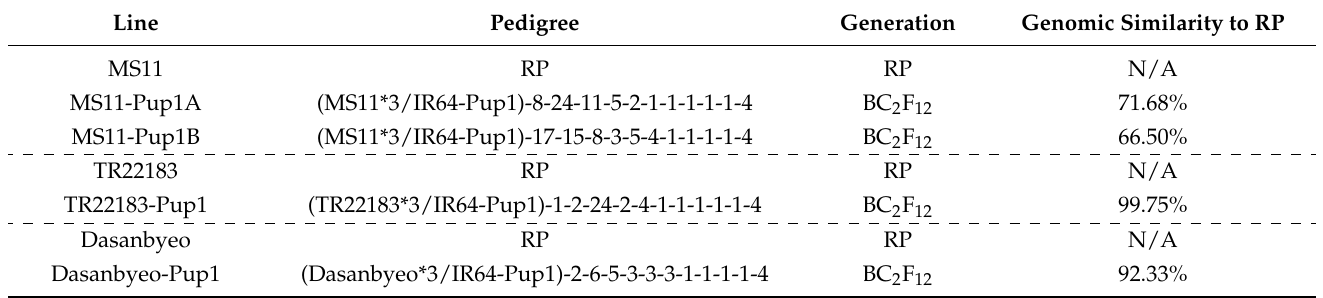
Figure 2. Homozygous full Pup1 locus marker validation at BC 2 F 12 , pre-replicated yield trials under low P and water inputs using a core marker set consisting of K46-1, K29-1, and K29-3 gel-based markers. M—DNA size marker (1kb+); bp—base pair; DP—donor parent allele; ND—recurrent (non-donor) parent allele. Table 1. RP genome recovery rates of the selected temperate Pup1 introgression rice lines. Recovery ratio was calculated as the number of markers with RP alleles within 1 Mb window for each chromosome relative to the total number of markers. RP represents the recurrent parents. “*” denotes the number of crosses to a parent.